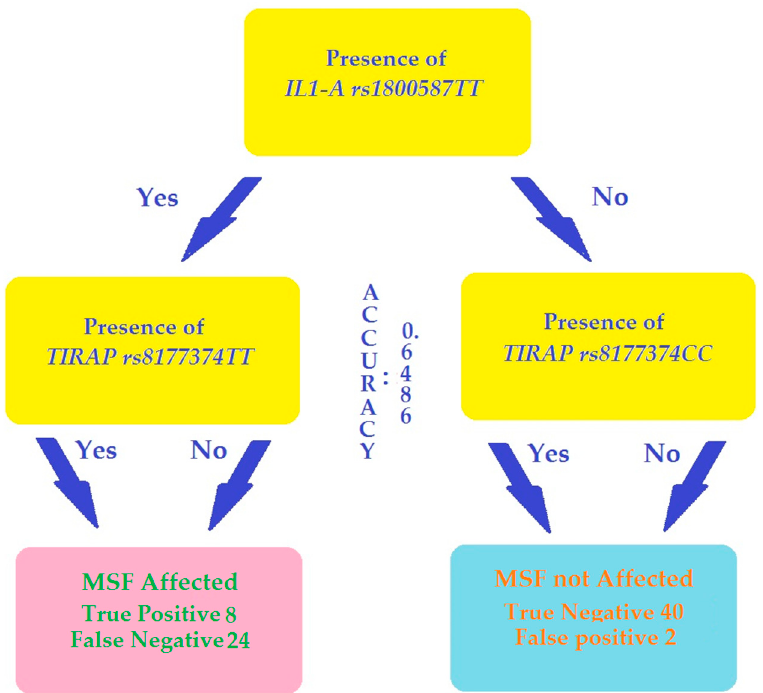
Figure 1. Decision tree algorithm. Data from 292 random selected case (128) and control (164) SNPs typing were used as a training set allow elaborating a decision rule that associates the positivity for